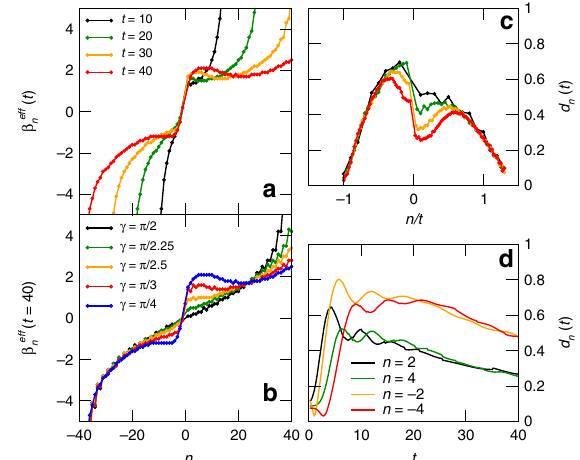
Fig. 4 Central equilibrium regions in the energy-transport scenario. Effective inverse temperatures: a pro fi le of β eff n for γ ¼ π = 4 and several values of time; b pro fi le of β eff n at the longest accessible time, t ¼ 40, and several values of γ . Equilibration tendency: c distance between the three- site reduced density matrices ρ n ; n ð t Þ and ρ n ; n ½ β eff n ð t Þ(cid:4) for several times þ 2 þ 2 and γ ¼ π = 4; d full time-evolution of the distance for four representative sites taken in both halves for γ ¼ π =